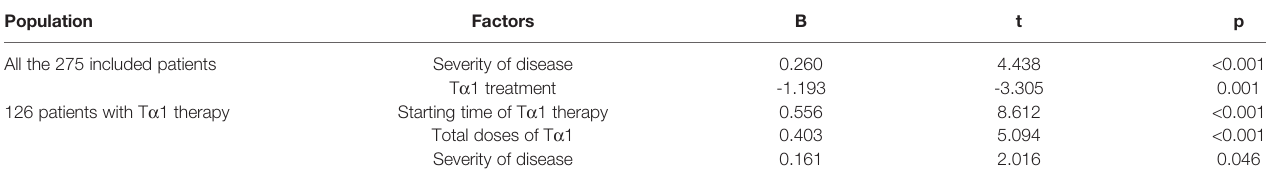
TABLE 3 | Multivariate analysis of factors correlated with the duration of virus shedding in the upper respiratory tract. Population Factors B t p All the 275 included